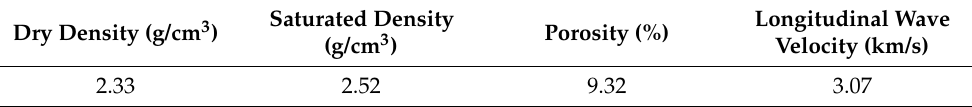
Figure 1. Test sample. Table 1. Summary of physical properties of sandstone